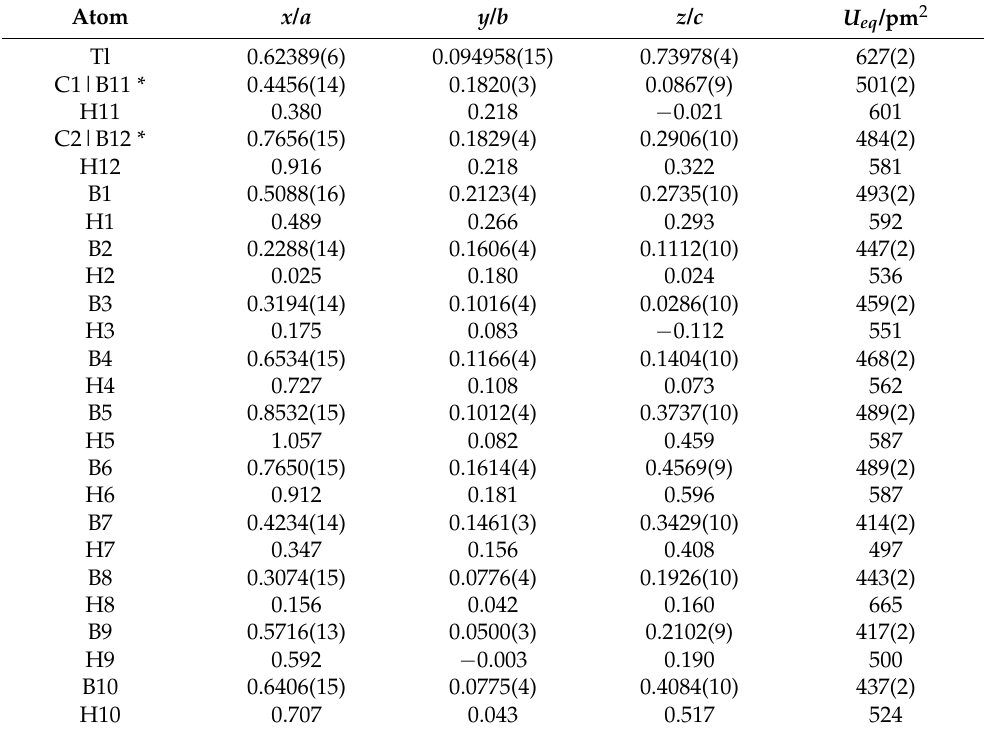
Table 2. Fractional atomic coordinates and equivalent isotropic displacement parameters of Tl[CB 11 H 12 ] (all atoms occupy the general Wyckoff site 4e